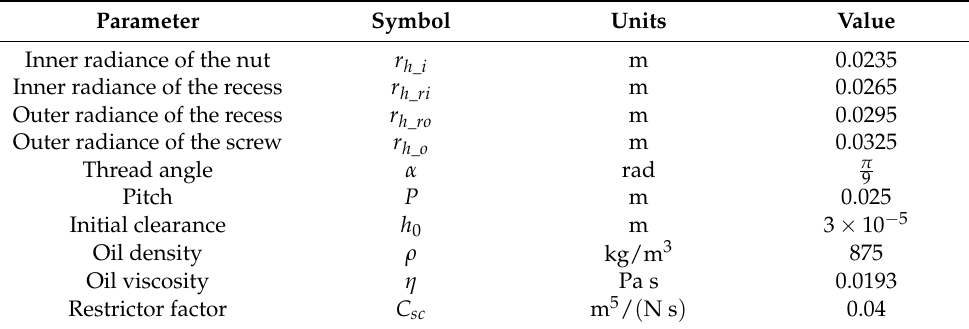
Table 1. Main parameters of the system.